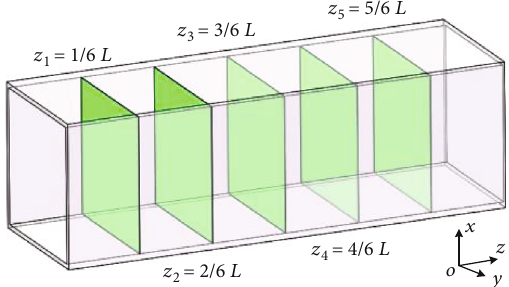
Figure 7: Transverse planes in the